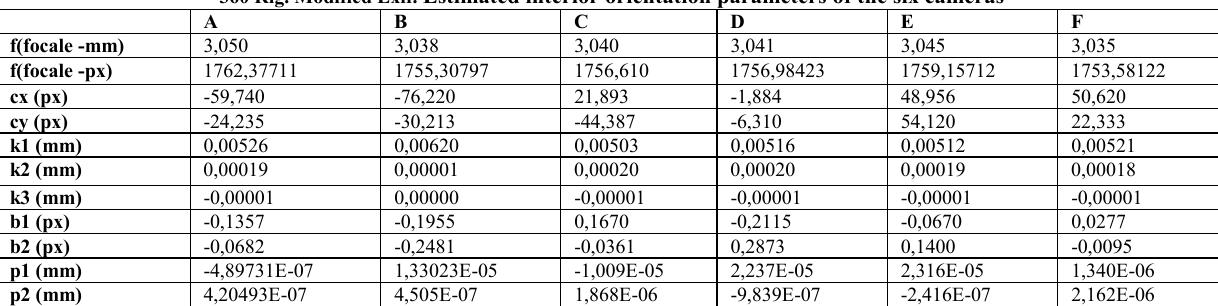
Table 4. Estimated interior orientation parameters of the six cameras mounted on the rig and processed after the Exif